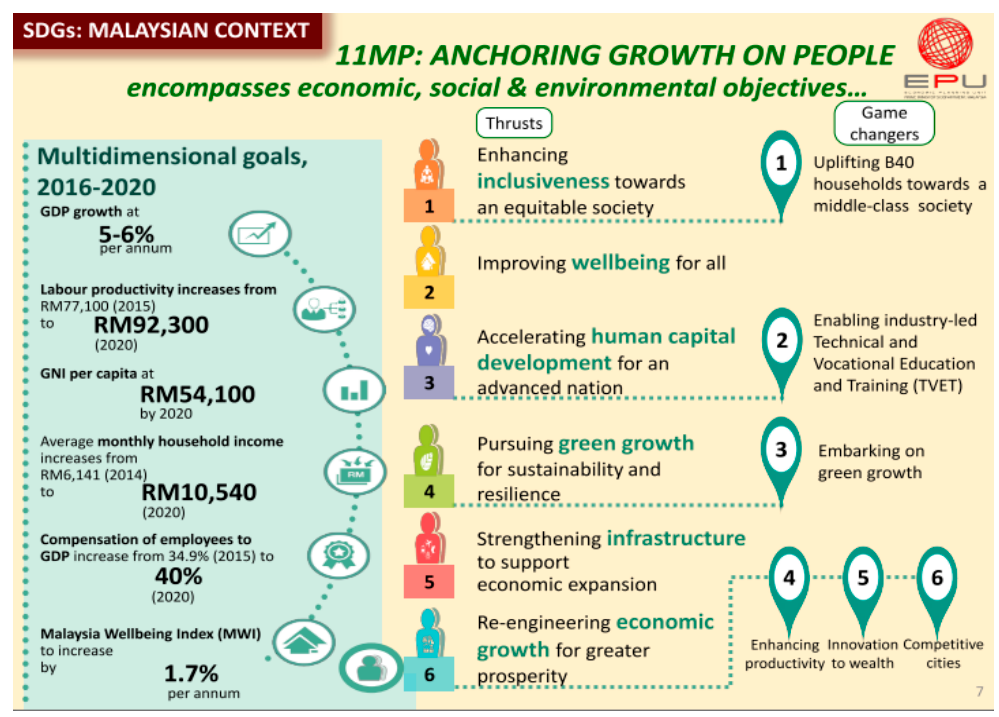
Figure 3. Malaysian Plan for Sustainable Development Goals. Source: Sustainable Development in Malaysia: “2030 AGENDA IN THE NATIONAL CONTEXT AND SDG ROADMAP” EPU, Malaysia.